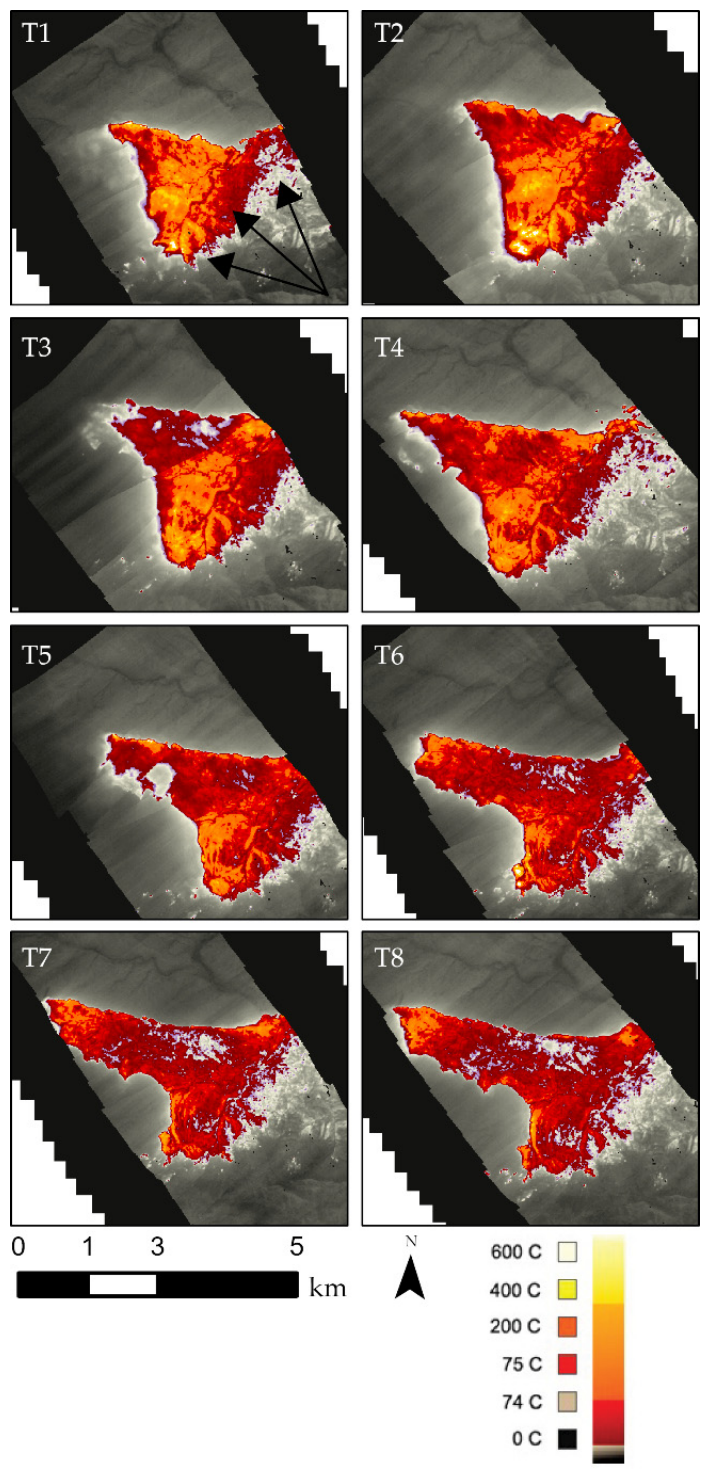
Figure 2. Portion of the Thomas ATIR image sequence 4. T1 to T8 indicate eight successive image passes showing the fire progression. Arrows in T1 image added to exhibit northwest (NW) direction of fire spread.